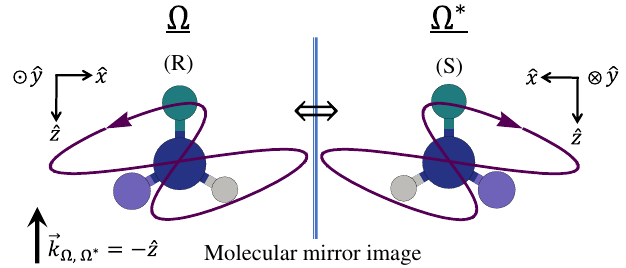
FIG. 2. Mechanism for destructive interference in HHG from racemic mixtures illustrated in scheme (A): For every orientation Ω of enantiomer (R), there exists a DA-equivalent orientation Ω (cid:2) for enantiomer (S) due to the reflection symmetry of the pump and the mirror image relation between the (R) and (S) enan- tiomers. These two orientations exactly destructively interfere for y -polarized HHG emission in the achiral ensemble (which differs by a sign between the two enantiomers for every orientation pair Ω ; Ω (cid:2) ). However, for nonracemic mixtures (nonzereo ee ), the destructive interference is incomplete, leading to y -polarized HHG emission. The purple Lissajou plot shows the overall vector pump field in the dipole approximation, and Ω and Ω (cid:2) denote the equivalent molecular orientations of (R) and (S) enantiomers that lead to destructive